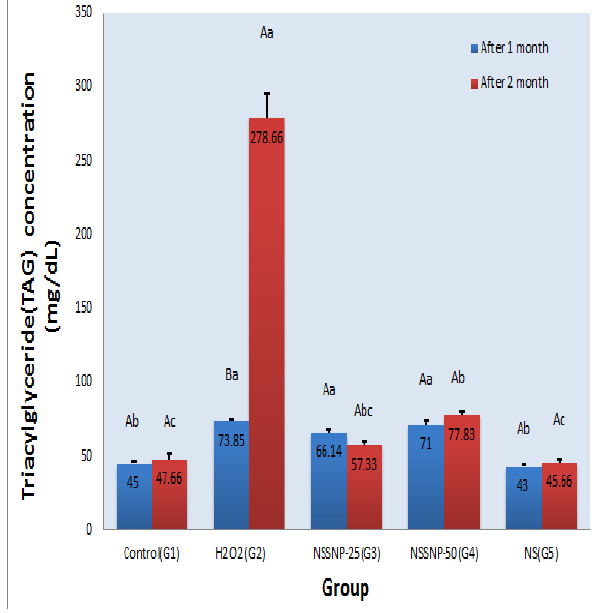
Figure 5. Effect of two concentrations of Nigella sativa seeds silver Nanoparticles NSSSNPs and Nigella sativa extract on serum triacylglyceride (TAG) concentration mg/dl in H O exposed rats. Values are expressed as 2 2 mean±SE (n= 8). Various capital letters denote significant differences at P<0.05 between periods.